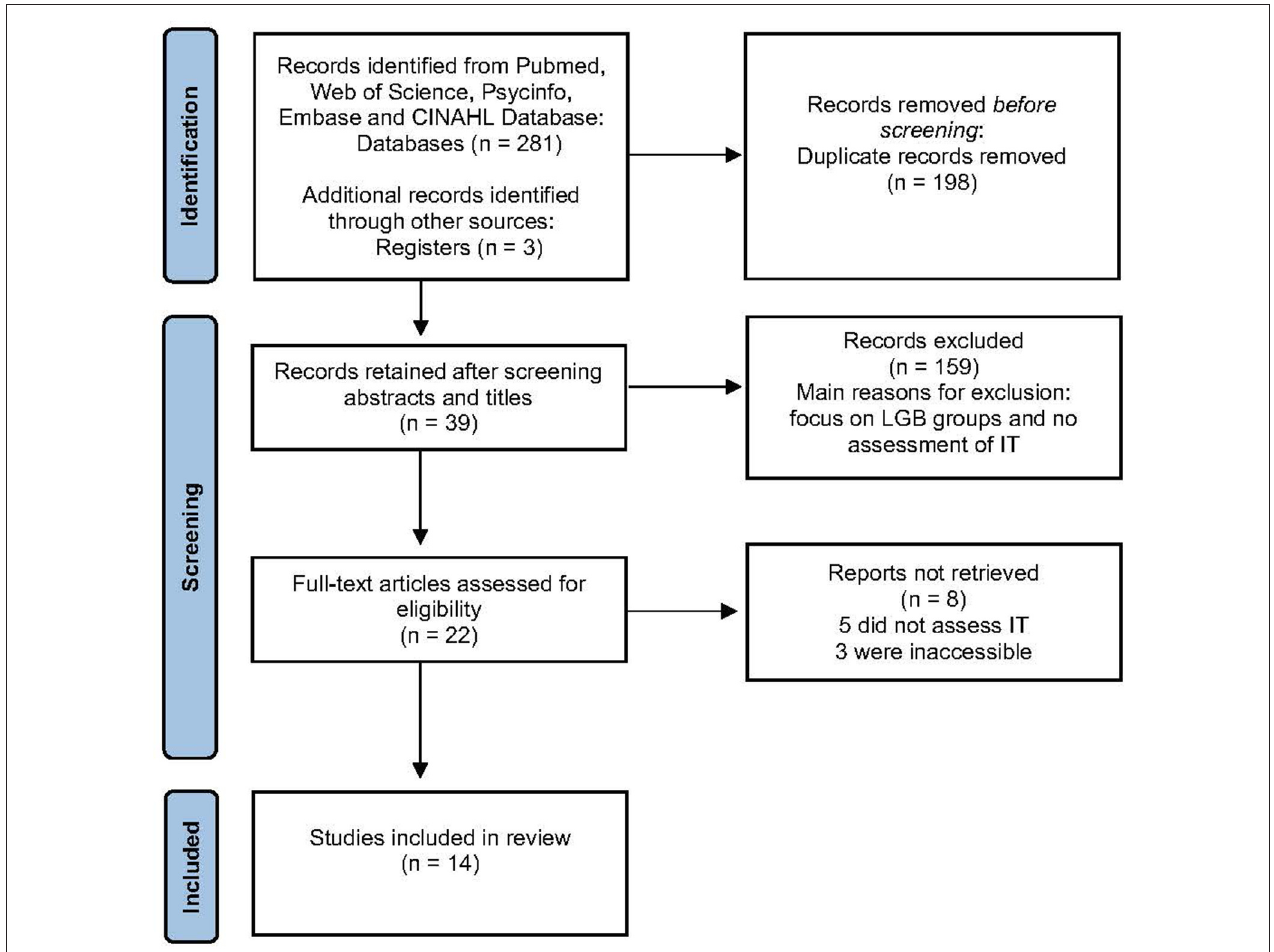
FIGURE 1 | PRISMA flow-diagram of systematic